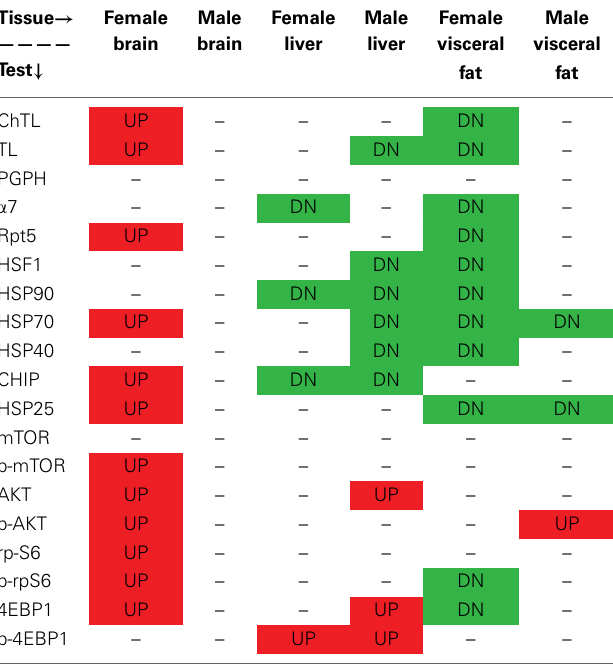
Table 1 | Rapamycin-influenced changes in markers of proteasome, chaperone, and mTOR pathway in old male and female brain, liver, and visceral fat